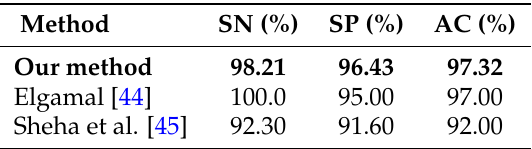
Table 2. Comparison of our method with other state-of-the-art